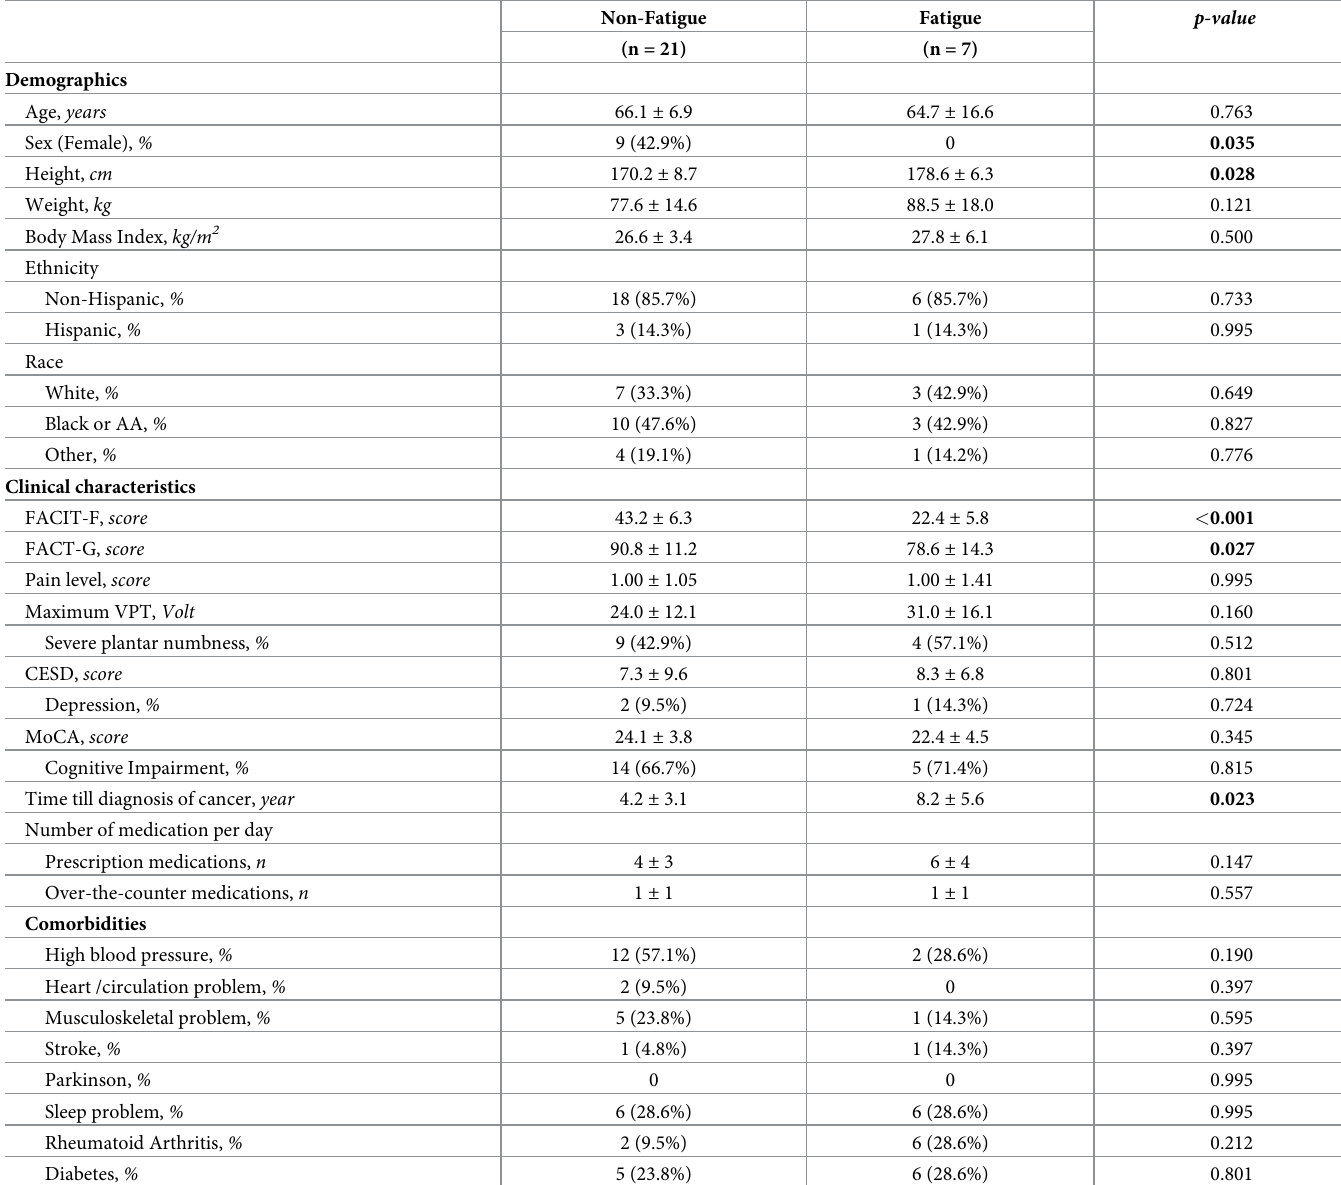
Table 1. Demographics and clinical characteristics of the study